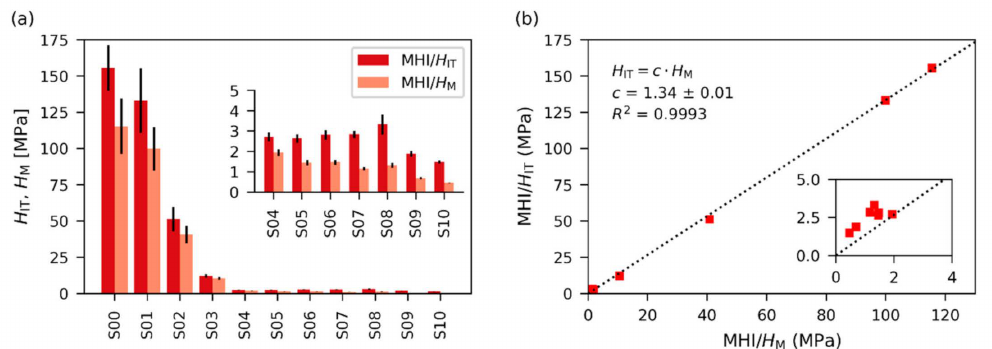
Figure 12. Results of quasi-static microindentation hardness testing: Di ff erence between the values of indentation hardness (MHI / H IT ) and Martens hardness (MHI / H M ). Left figure ( a ) shows the di ff erence between absolute values and right figure ( b ) shows the correlation between the two quantities. Error bars in left figure represent standard